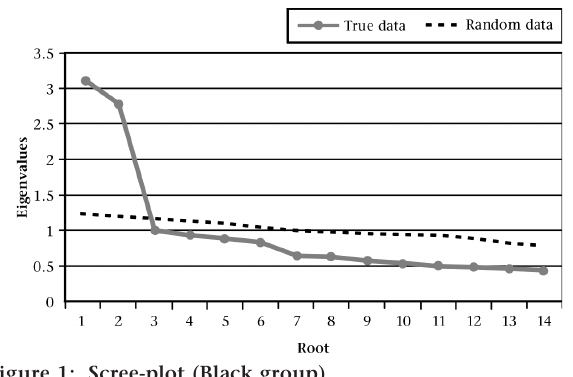
Figure 1: Scree-plot (Black